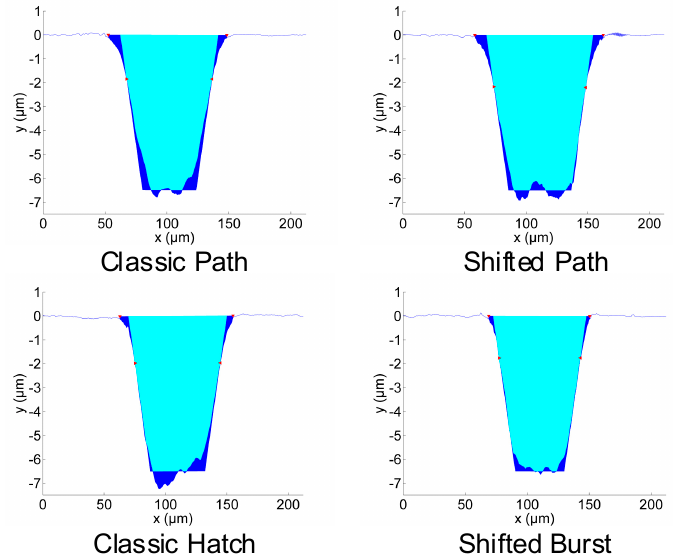
Figure 7. Measured relative deviation of the dimple depth profile for different laser texturing methods (scanning strategies) at their highest allowed scanning speeds.